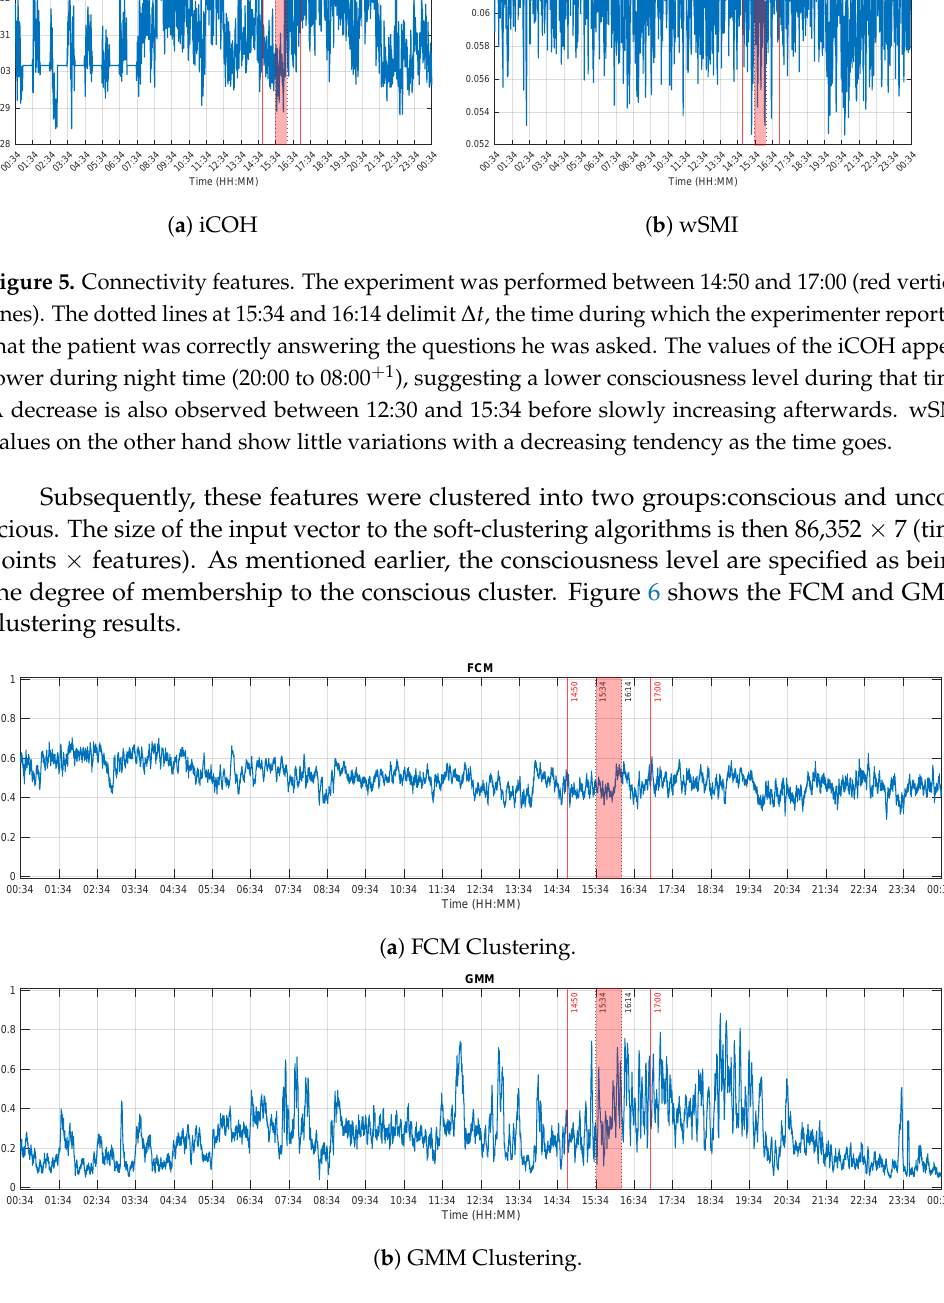
Figure 6. Outputs of the clustering analyses. The x-axis represents the recording times, while the y-axis displays the estimated consciousness levels. A value of 0 corresponds to unconsciousness and a value of 1 means that the patient is conscious. The experiment was performed between 14:50 and 17:00 (red vertical lines). The dotted lines at 15:34 and 16:14 delimit ∆ t , the time during which the experimenter reported that the patient was correctly answering the questions he was